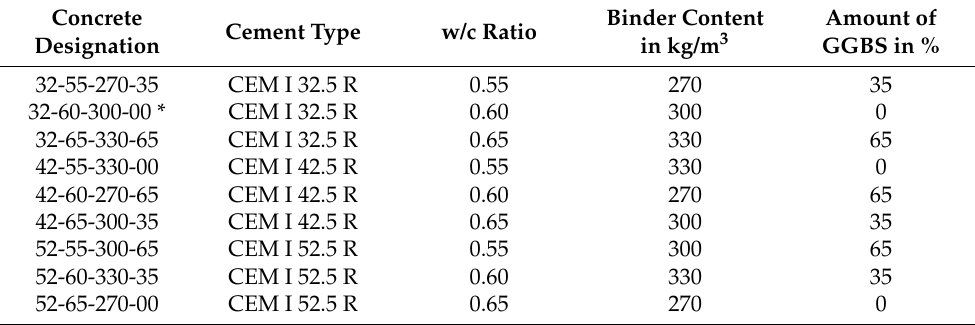
Table 4. Statistical concrete matrix with combined variations.